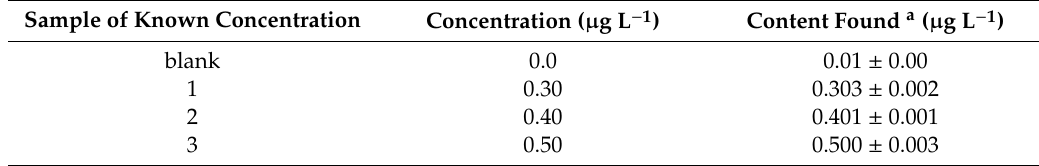
Table 2. Results of validation of the proposed procedure in aqueous solutions presenting known concentrations of BPA. Sample of Known